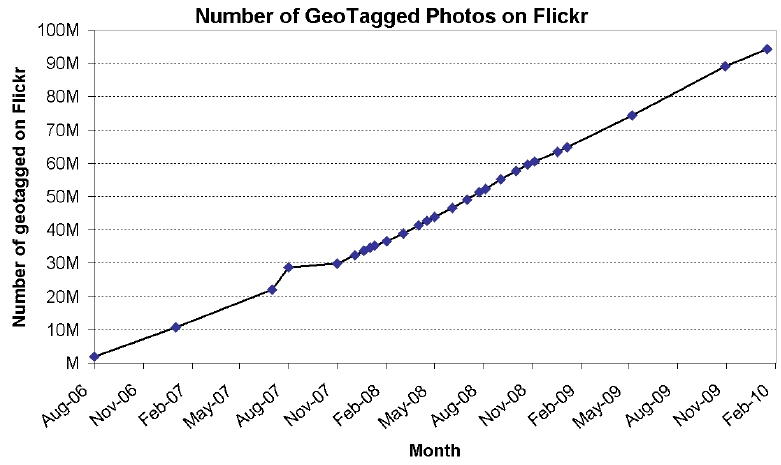
Figure 3. Number of geotagged photos on